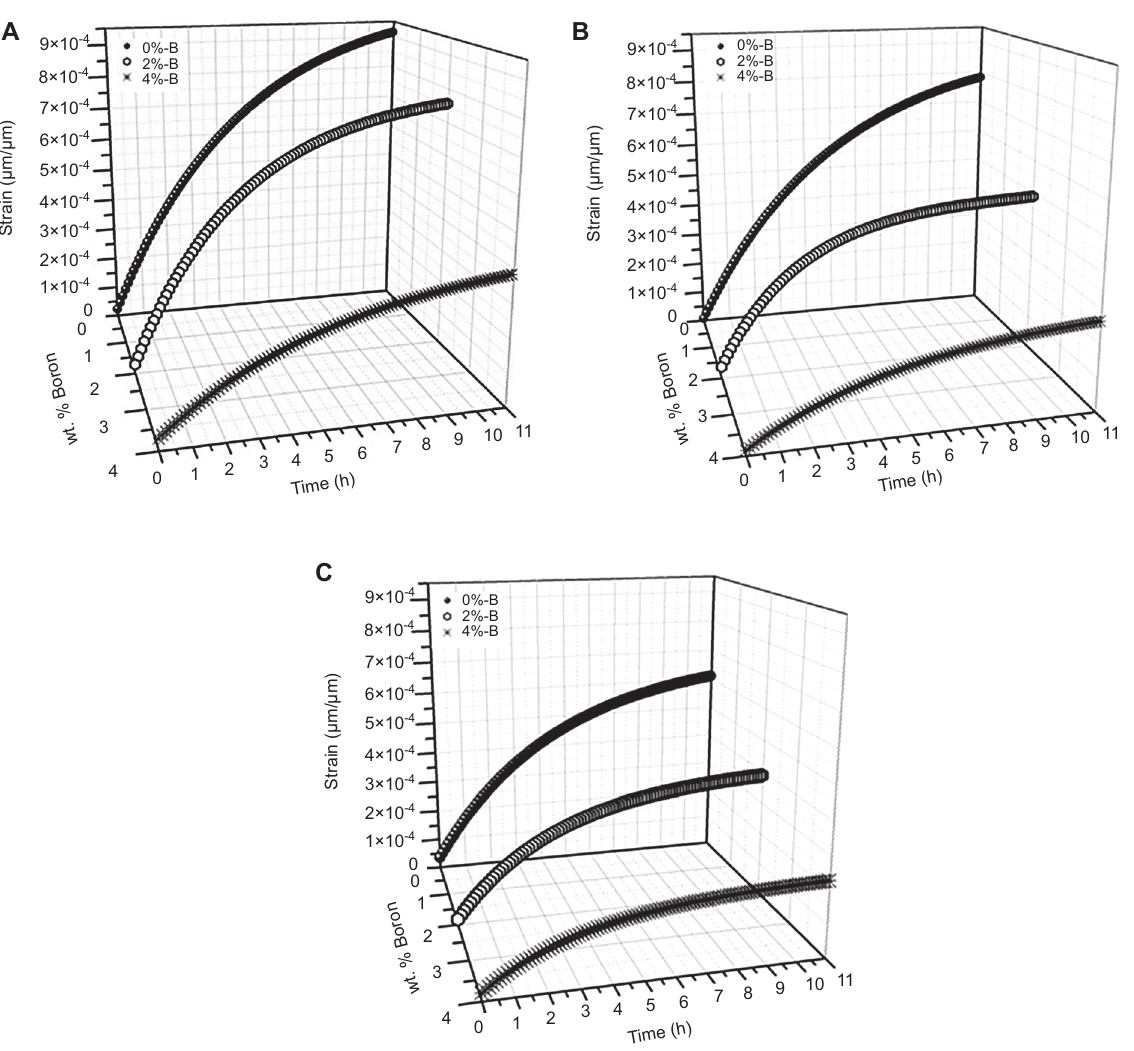
Figure 4 Compressive creep curves of Al-Cu reinforced with diboride particles at 500 ° C and at different applied loads: (A) 1 N, (B) 0.7 N, (C) 0.5